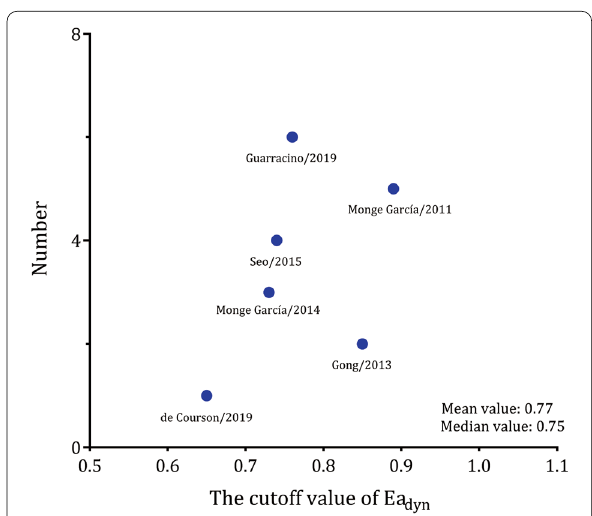
Fig. 4 Scatter plot of the cut-off value of dynamic arterial elastance. The distribution was nearly conically symmetrical, most data were centred between 0.7 and 0.8, and the mean and median values were 0.77 and 0.75,